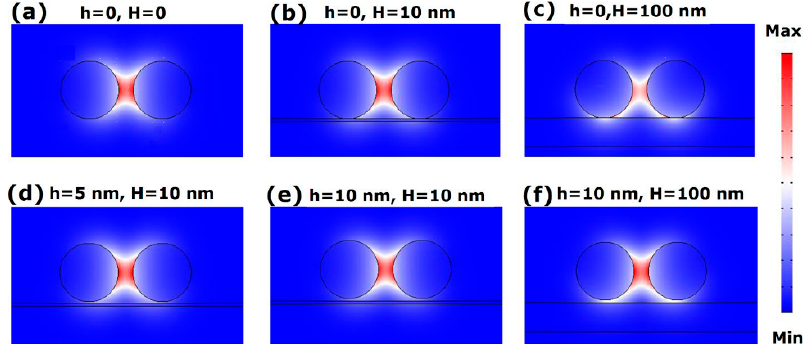
Figure 2. Normalized electric field distributions of the fundamental graphene plasmon mode (FGPM) with different gap sizes and thicknesses of substrate at 30 THz, where R 1 = R 2 = 100 nm, μ c = 0.6 eV, D = 50 nm, W = 1000 nm, ε 1 = 2, and ε 2 = 2.25. ( a ) [ h , H ] = [0,0], N eff = 22.467 + 0.21479 i , corresponding to the situation of a graphene-covered nanowire pair in air; ( b ) [ h , H ] = [0,10] nm, N eff = 22.750 + 0.21675 i;